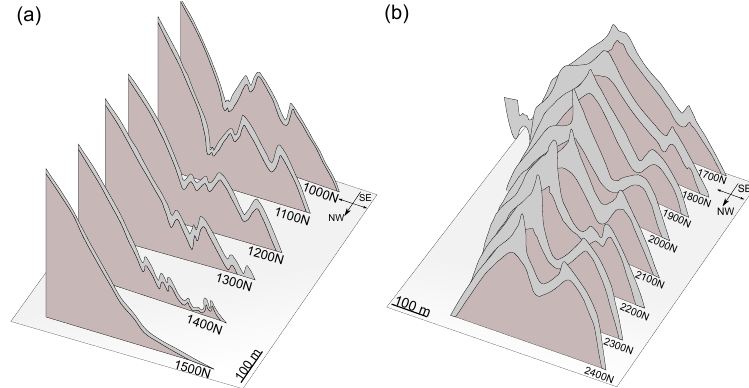
Figure 11. Fence diagrams of cross-sections. View towards the SW of the COM (a) section 13 between 2700 and 3300 level (in feet) and between 1700 and 2400mN in Nkana Central and (b) section 14 between 2500 and 3300 level (in feet) and between 1000 and 1500mN in Nkana Central. The diagrams are based on a reconstruction from geological maps, boreholes and subsection plans of Mopani Mines Plc. in the Vulcan software. The COM is shown in grey and various underlying formations are given in red. The plane in light grey represents the horizontal plan of 3300L level. (a) The COM is strongly pinched out, and small parasitic folds evolve into major folds from SE to NW as an en echelon fold system. (b) In the NE a strongly developed parasitic second-order fold is seen with multiple third-order folds. This second-order fold gradually dies out towards the NW over a distance of approximately 500m.